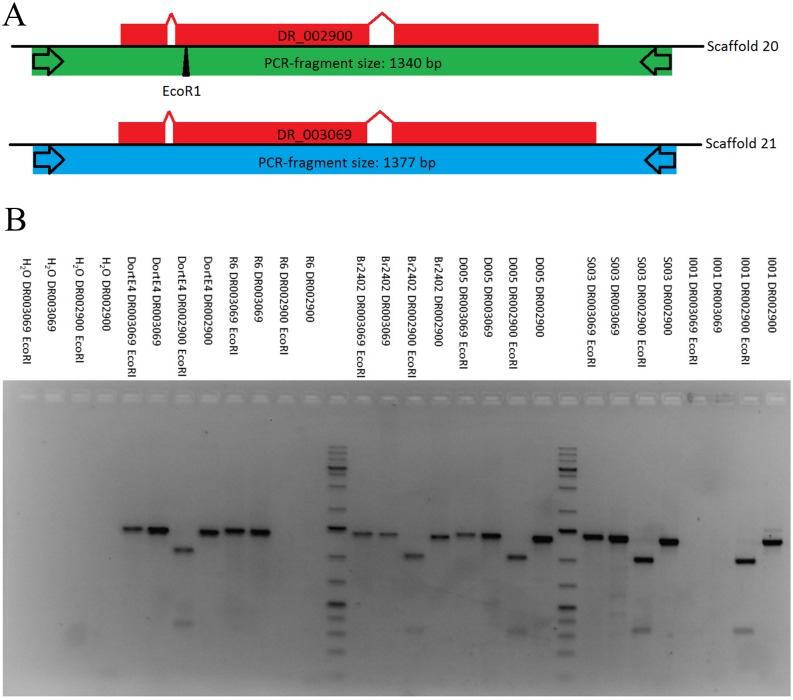
PCR-RFLP analysis of pairs of BUSCO orthologs.A: Schematic display of the method. Specific primers were developed that distinguish between the two very similar paralogs. As second distinctive feature only one of the two PCR fragments contains an EcoRI or DraI restriction site. B: Gel image of a PCR-RFPL analysis of the paralogous sequences DR002900 and DR003069 with six different isolates. Ladder: 1 KB plus (Thermo Fisher, Waltham, USA).